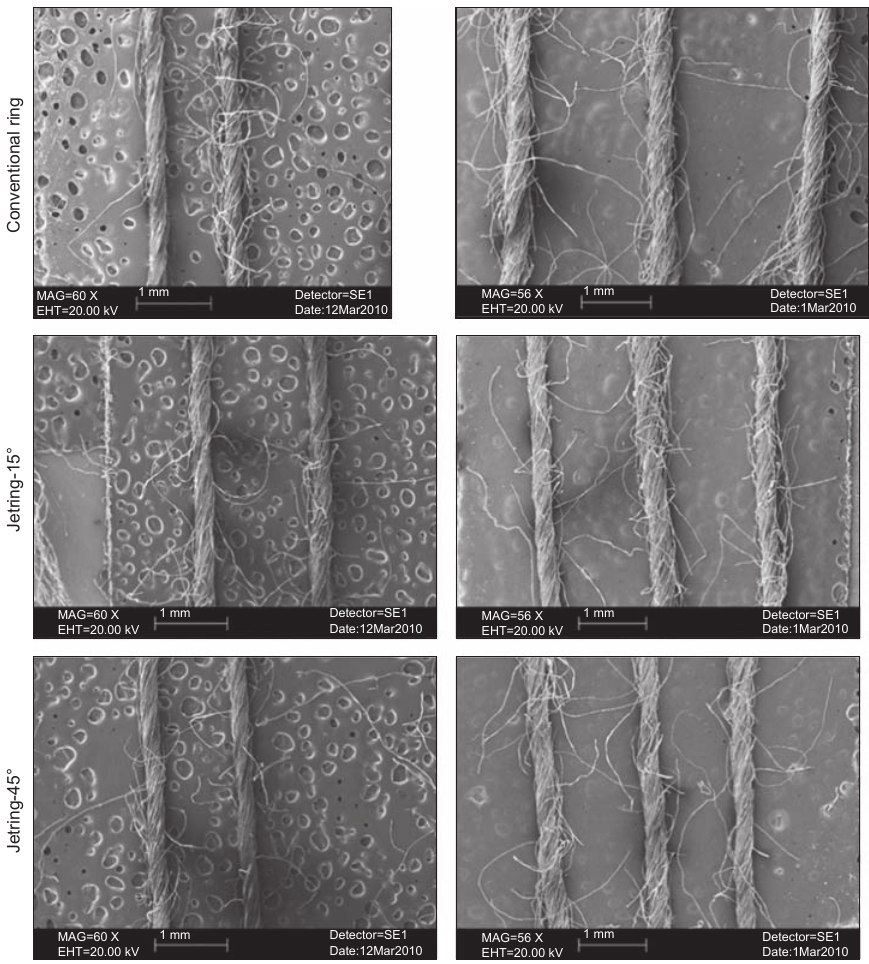
Figure 5 Typical views of the yarns (60 ×